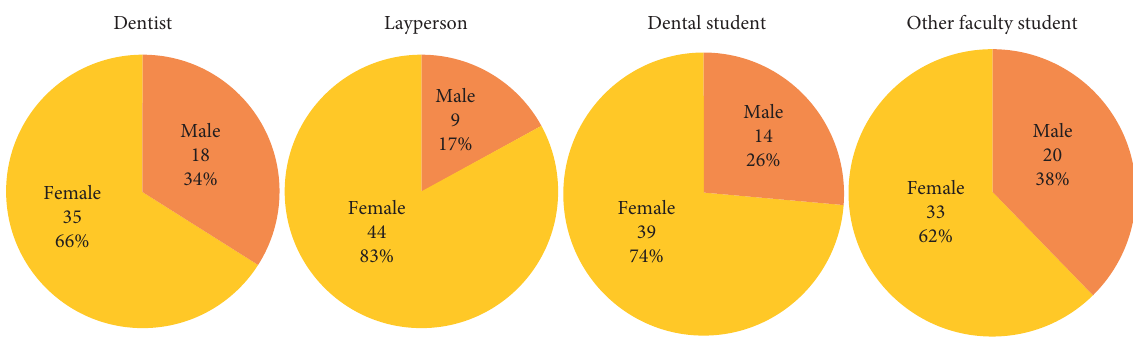
Figure 3: Percentage of males and females in each rater